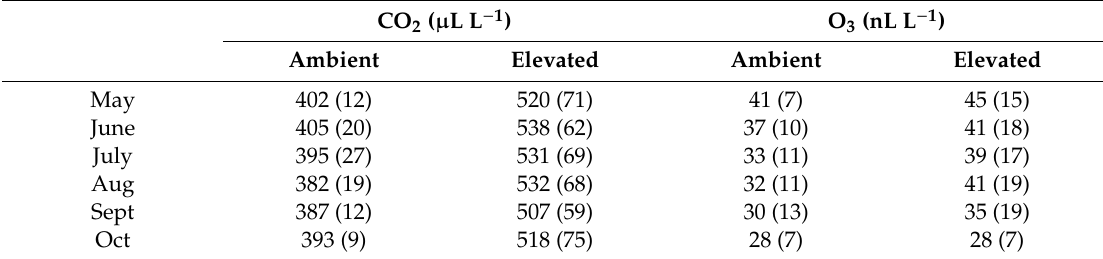
Table 1. Mean of six experimental rings (SD) of hourly concentrations of CO 2 and O 3 at the Aspen Free Air CO 2 Enrichment (FACE) site for the hours from sunrise to sunset during the fumigation season 2008